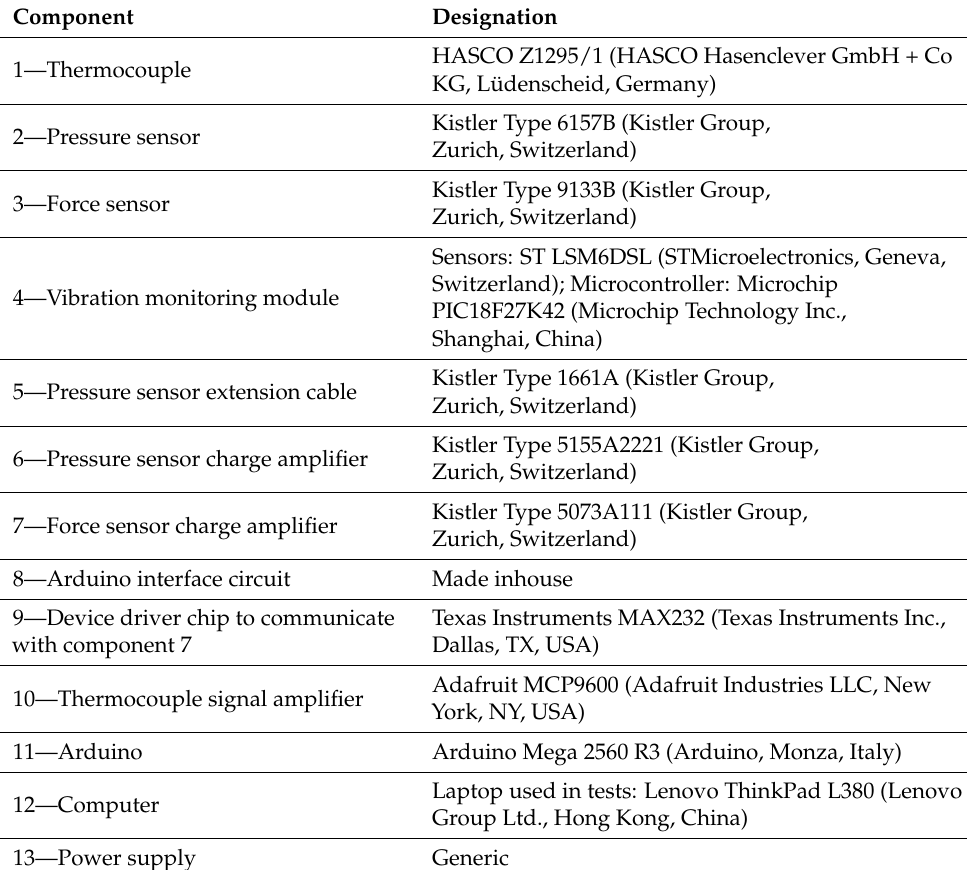
Table 1. List of the main components used to develop the monitoring system and corresponding